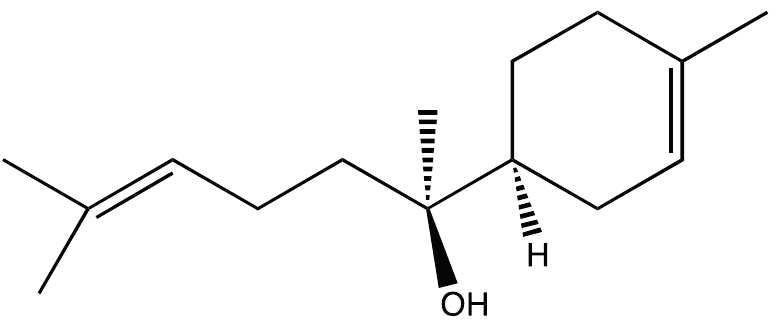
Figure 1. Chemical structure of α -bisabolol.